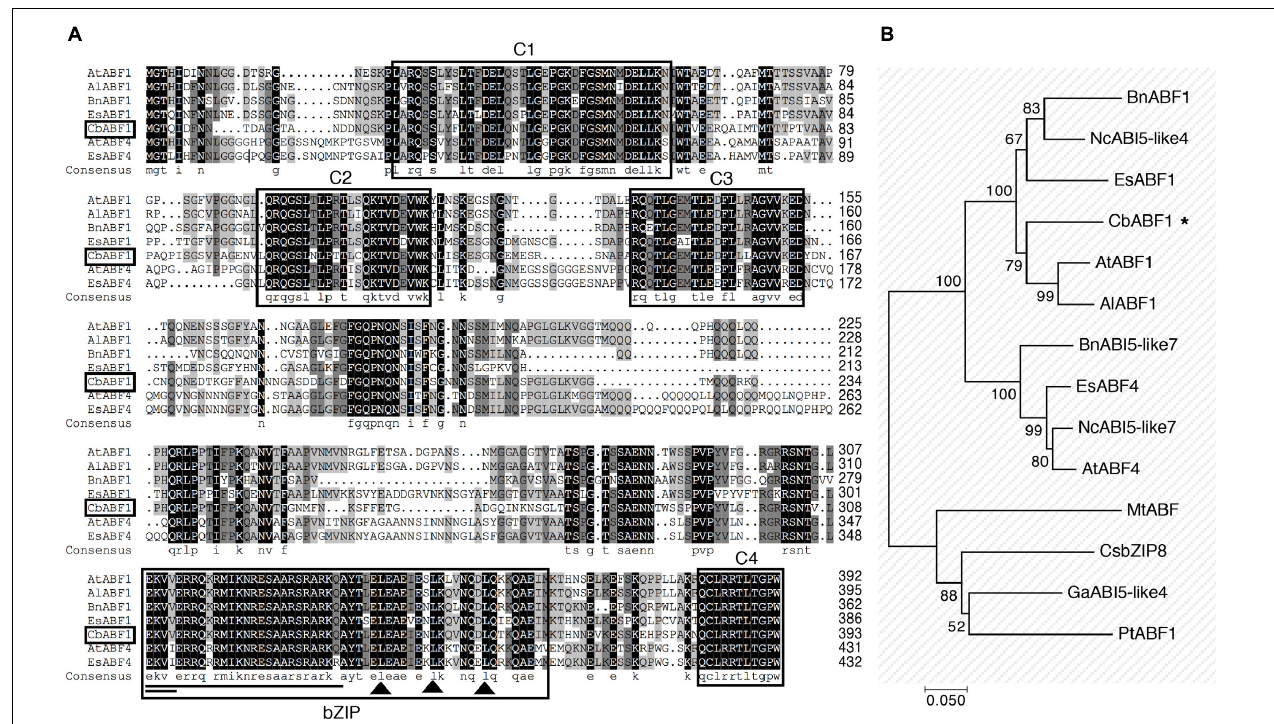
FIGURE 2 | Sequence analysis of CbABF1. (A) Multiple sequence alignment of the deduced amino acid sequence of CbABF1 with its close orthologs. Compared proteins are from Arabidopsis thaliana (AtABF1, NP_564551.1; AtABF4, NP_566629.1), Arabidopsis lyrata subsp. lyrata (AlABF1, XP_002891529.1), Brassica napus (BnABF1, AGG35955.1), and Eutrema salsugineum (EsABF1, AFN84600.1; EsABF4, AFN84603.1). Black and gray shaded backgrounds indicate identical or similar amino acids, respectively. The basic region and the three heptad leucine repeats, two important bZIP signatures, are shown by a single line and black triangles, respectively. C1, C2, C3, and C4 are conserved regions containing residues of serine and threonine. A nuclear localization signal is highlighted by the double line. (B) Phylogenetic relationships between CbABF1 and its orthologs. The phylogenetic tree was constructed by the neighbor-joining method in MEGA 7.0. The numbers in the branches are the bootstrap values from 1000 replicates expressed as percentages. The sources of the CbABF1 orthologs and accession numbers are: BnABF1, Brassica napus (AGG35955.1), NcABI5-like4, Noccaea caerulescens (JAU90609.1), EsABF1, Eutrema salsugineum (AFN84600.1), CbABF1, Chorispora bungeana (MH213062), AtABF1, Arabidopsis thaliana (NP_564551.1), AlABF1, Arabidopsis lyrata (XP_002891529.1), BnABI5-like7, Brassica napus (NP_001303205.1), EsABF4, Eutrema salsugineum (AFN84603.1), NcABI5-like7, Noccaea caerulescens (JAU59323.1), AtABF4, A. thaliana (NP_566629.1), MtABF, Medicago truncatula (XP_003607958.1), CsbZIP8, Camellia sinensis (AGG39700.1), GaABI5-like4, Gossypium arboreum (KHG05529.1), and PtABF1, Populus trichocarpa (XP_006384405.1). CbABF1 was labeled by an